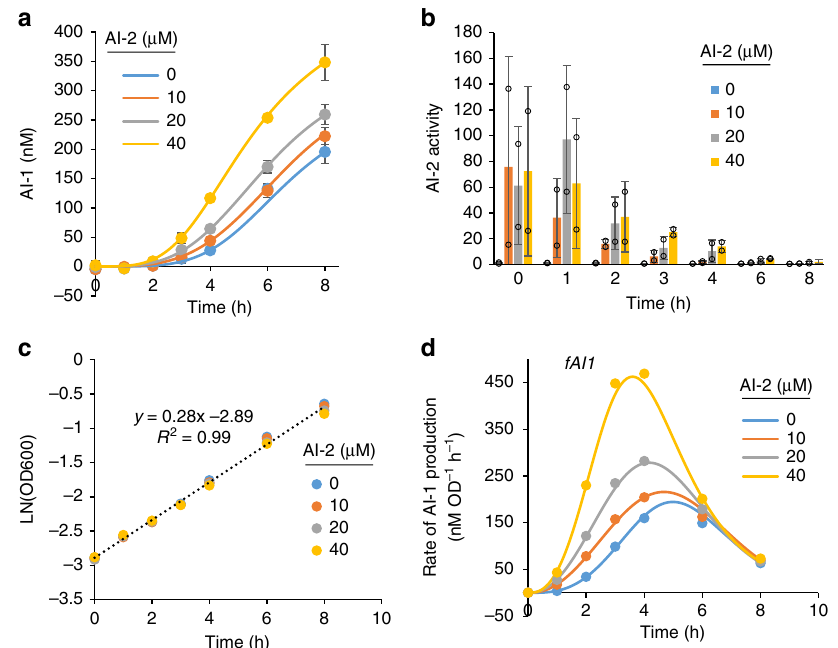
Fig. 5 Characterization of AI-1 production in translator cells. PH04 translator cells cultured in M9 glucose media with varying concentrations of AI-2. Cells were inoculated from overnight cultures and AI-2 was added as indicated at t = 0. a Extracellular AI-1 levels over time. Error bars represent s.d. of technical duplicates. b Extracellular AI-2 activity over time. Error bars represent s.d. of technical duplicates. c Cell density over time. d Functions for AI-1 production rate, fAI1 , for different AI-2 concentrations (solid lines) and AI-1 production rates calculated with experimental data (dots). Source data are provided as a Source Data fi